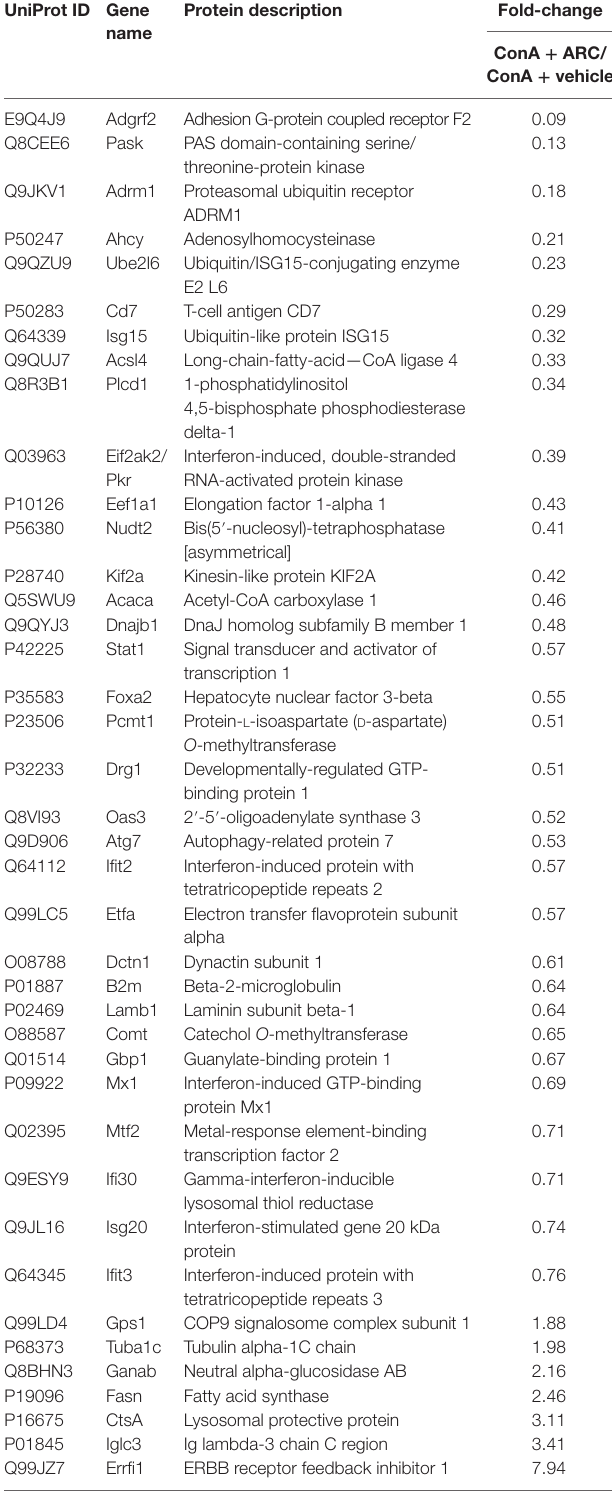
Table showed the mean fold changes of proteins in ARC pre-treated model group verses vehicle group with p values less than 0.05 (n = 3), where ratios > 1.25 were upregulation; ratios < 0.8 were